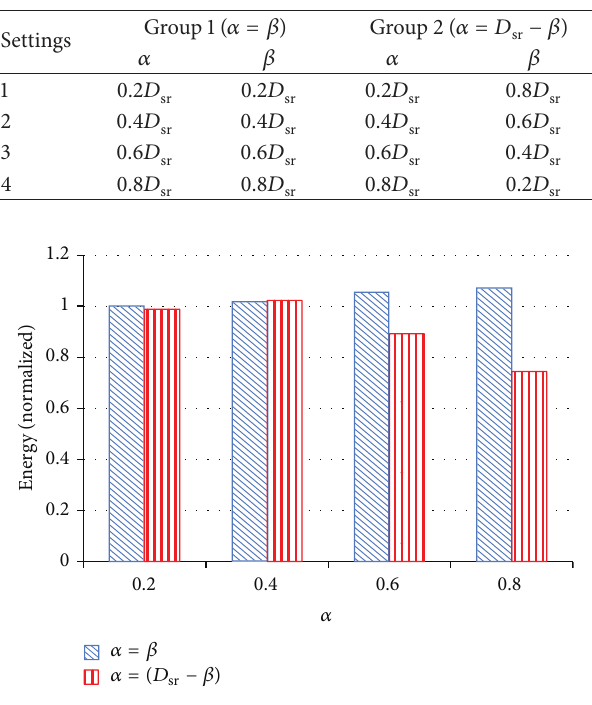
Figure 4: Energy comparison between original D 3 VFS and ED 3